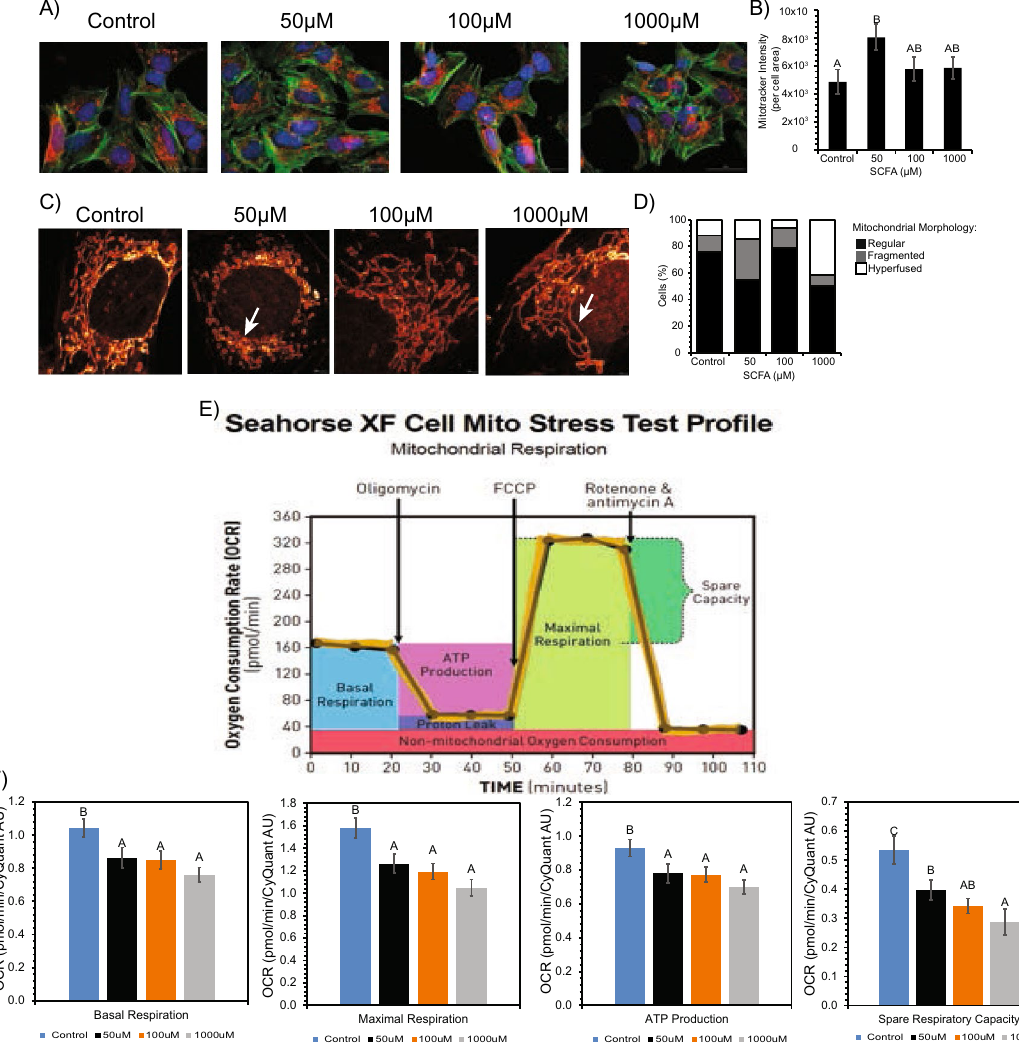
Figure 4. Morphological changes observed in the mitochondria between control vs SCFA treated neuronal cells. ( A ) Mitotracker Deep Red under Cytation3 Imaging revealed increased dye intensity after treatment. ( B ) Bar graph numerically represents increase in dye intensity. Bars represent mean ± standard error. Different superscripts represent statistically significant increase (p < 0.05). ( C ) STED imaging revealed fragmented (50 μM) and hyperfused (1000 μM) mitochondria after treatment. ( D ) 100% stacked column graph numerically represents relationship of regular, fragmented and hyperfused mitochondria per treatment. ( E,F ) Decrease in respiratory capacity and ATP production in neuronal cells after treatment. ( E ) Representative of general mitochondrial stress test profile and outputs from Seahorse XF as it measures OCR over time (from Agilent). ( F ) Seahorse XF analysis results after SCFA treatment showing an overall decrease in basal respiration, maximal respiration, ATP production, and spare respiratory capacity. Bars represent means ± standard error. Different superscripts represent statistically different (p < 0.05) decreases in respiration and